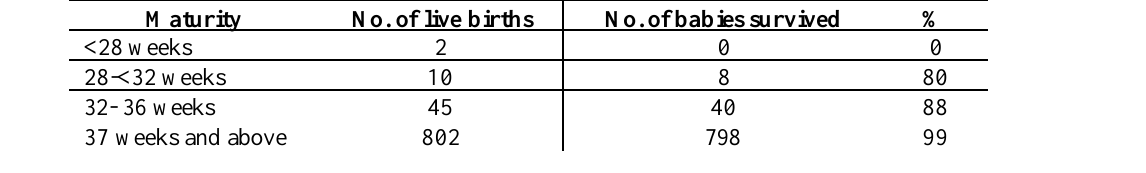
Table VI : Survival of babies born at KMCTH by